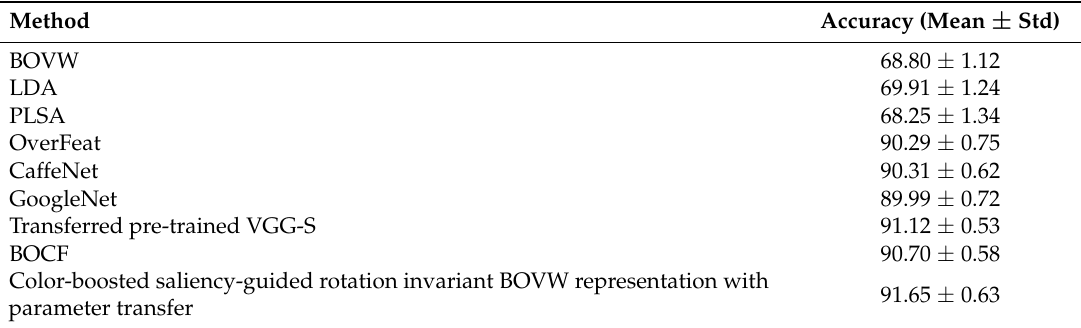
Table 5. Comparison with state-of-the-art methods in the SIRI-WHU dataset in classification accuracy.